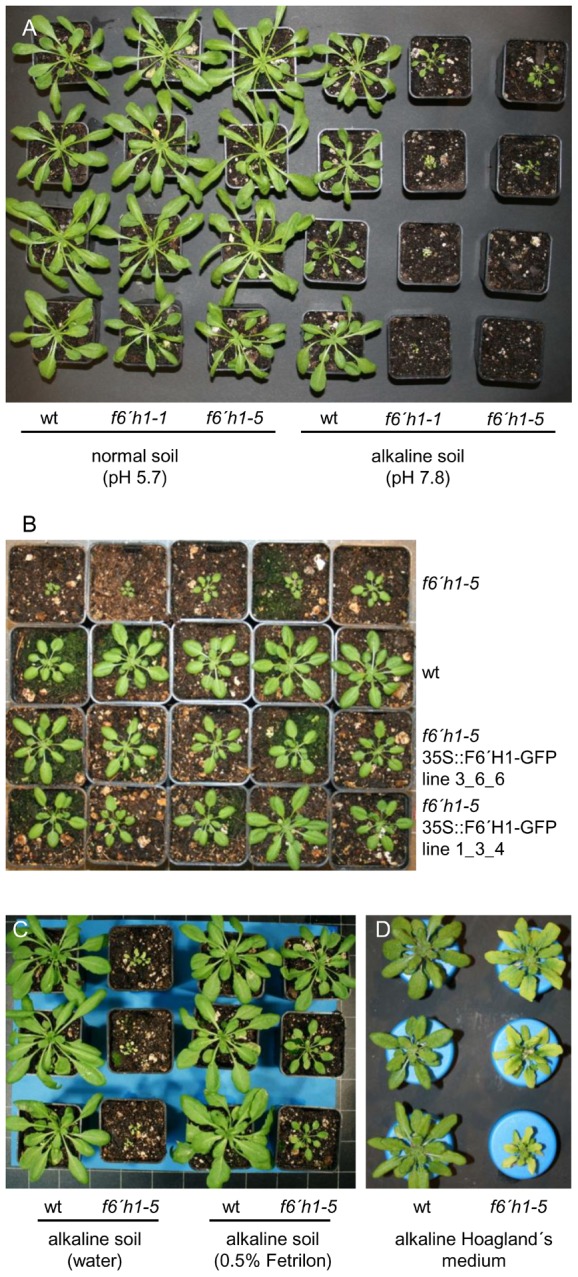
Growth of coumarin-deficient f6′h1 T-DNA insertion mutants is strongly impaired under Fe-limited alkaline conditions.(A) A. thaliana wild type plants (wt) and f6′h1 T-DNA insertion mutants f6′h1-1 and f6′h1-5 were grown on normal soil (left) and on soil alkalinized through the addition of CaO (right). (B) Overexpression of F6′H1 under control of the 35S promoter in f6′h1-5 fully rescues the mutant phenotype on alkaline soil. Shown are two independent transgenic lines grown alongside the wild type and the f6′h1-5 mutant on alkaline soil. (C) The mutant phenotype on alkaline soil can be partially rescued by Fe fertilization through watering with 0.5% Fetrilon (Fe-EDTA solution). (D) Col-0 wild type plants (wt, left) and f6′h1-5 mutant plants (right) were cultivated for six weeks in hydroponic medium with a pH of 7.7 instead of 5.7. All experiments were repeated three times independently with nearly identical outcome. The individual plants shown represent the range of phenotypes observed.